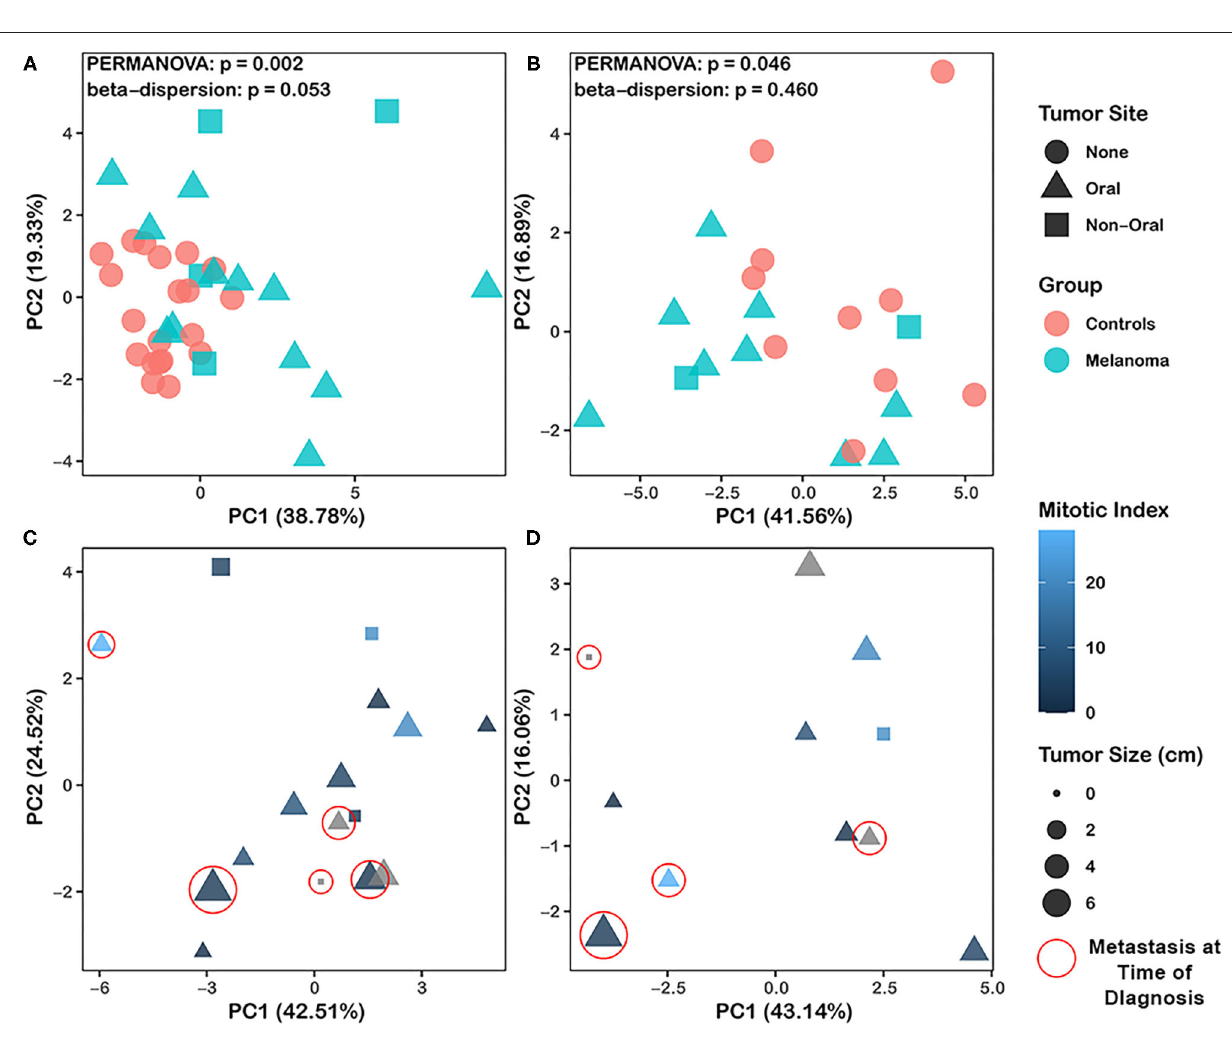
FIGURE 2 | Principal component analysis (PCA) of immunophenotype in melanoma and healthy control patients. (A) PCA including 17 immunophenotypes and 36 animals (20 healthy controls, 16 melanoma patients) is shown. (B) PCA including 23 background subtracted immunophenotypes after stimulation with ConA and 21 animals (10 healthy controls, 11 melanoma patients) is shown. (A,B) Patients are discriminated for melanoma site. Orange circles represent healthy control animals; teal-colored dots denote melanoma patients, which are further categorized into oral melanoma (triangle) and non-oral melanoma (square). (C) PCA including 17 immunophenotypes and 16 melanoma patients. (D) PCA including 22 background subtracted immunophenotypes after stimulation with ConA and 11 melanoma patients. (C,D) Patients are discriminated for melanoma site, tumor mitotic index, tumor size, and metastasis. Triangle points represent patients with oral melanoma; square points represent patients with non-oral melanoma. Points are colored based on mitotic index, from dark to bright blue. Patients with missing mitotic index are denoted by gray color. Size of data points correspond to size of the tumor. Patients with metastasized melanoma are circled in red. PCA was performed using R version 4.1.0. P -values < 0.05 are considered significant.